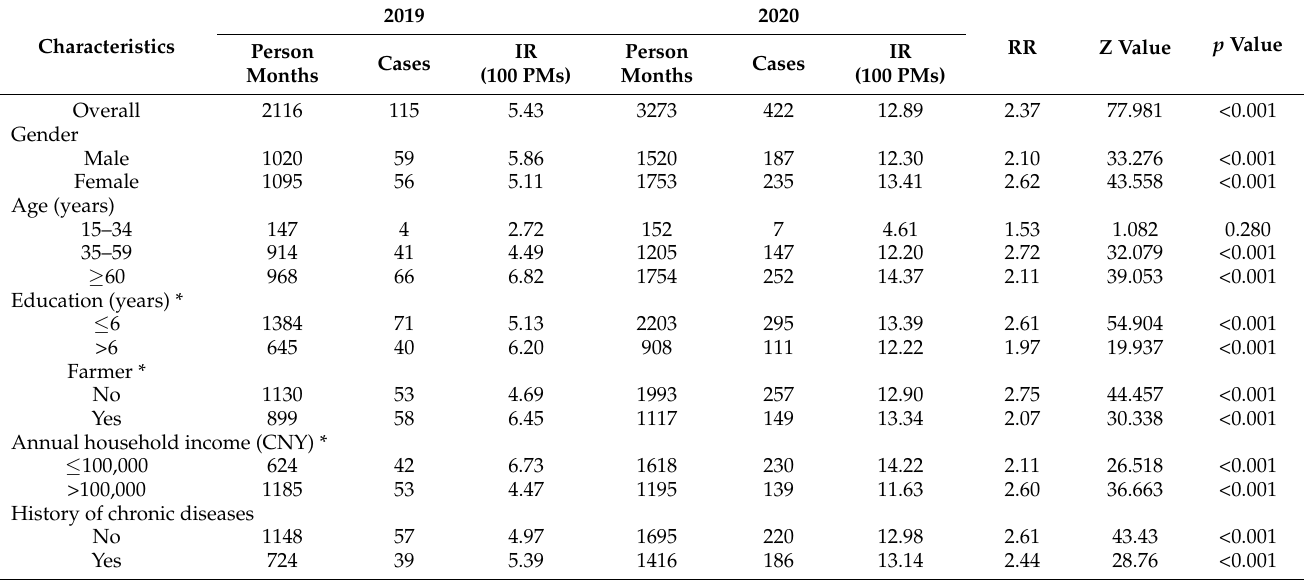
Table 2. Changes in the risk of antibiotic use between 2019 and 2020 among the study population in Eastern